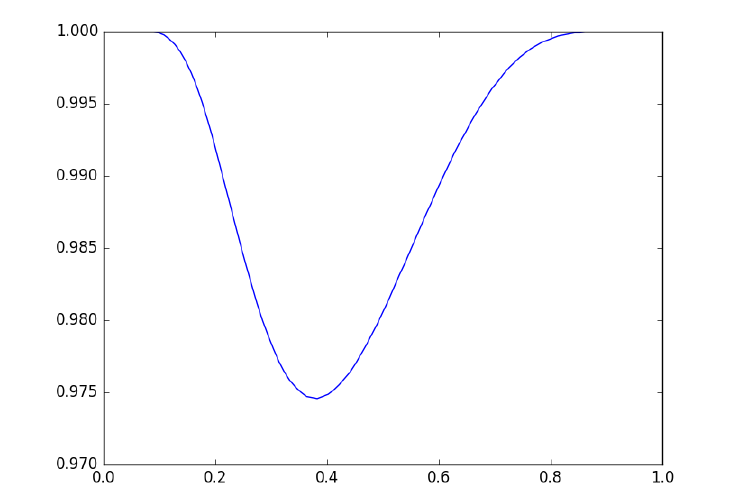
1 when a is varying in ] 0,1 [ 1 + λ ( a ) e − µ ( a ) x